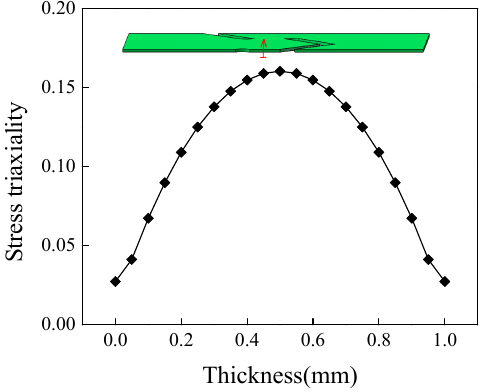
Figure 8. Stress triaxiality along center line of minimum cross-section in thickness direction for specimen S-0.